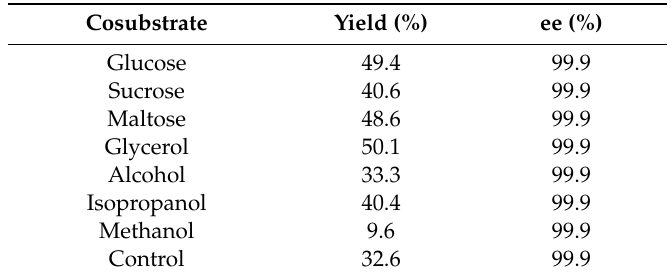
Table 2. E ff ect of di ff erent cosubstrates on the asymmetric reduction.